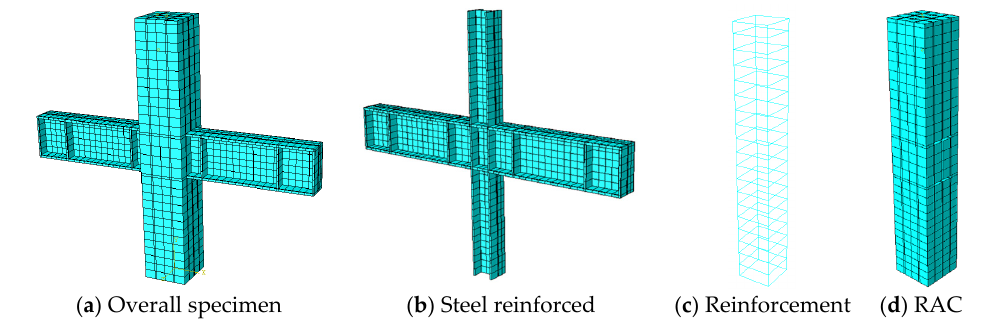
Figure 12. Mesh division of composite joints.